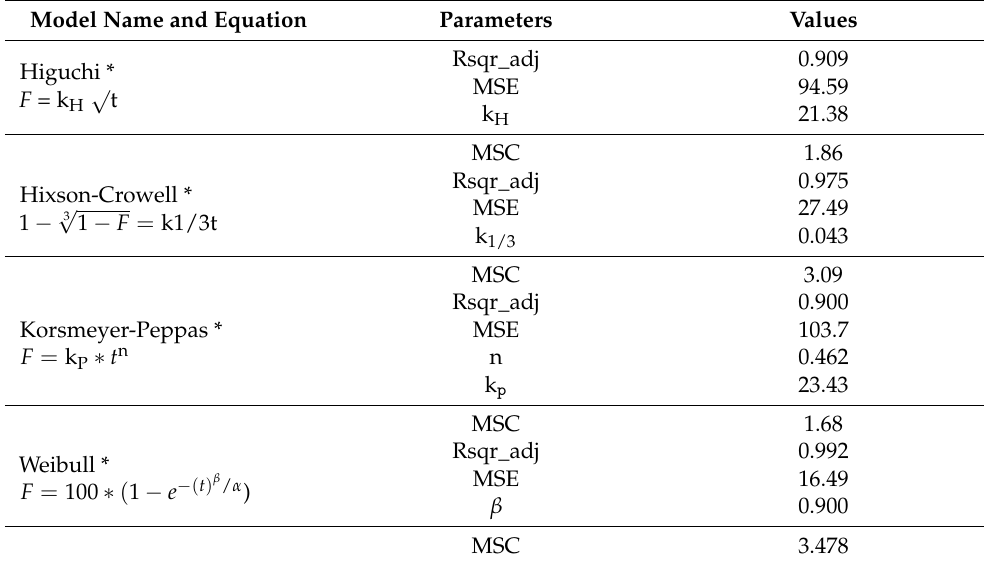
Table 4. Parameters of the different kinetic models for the